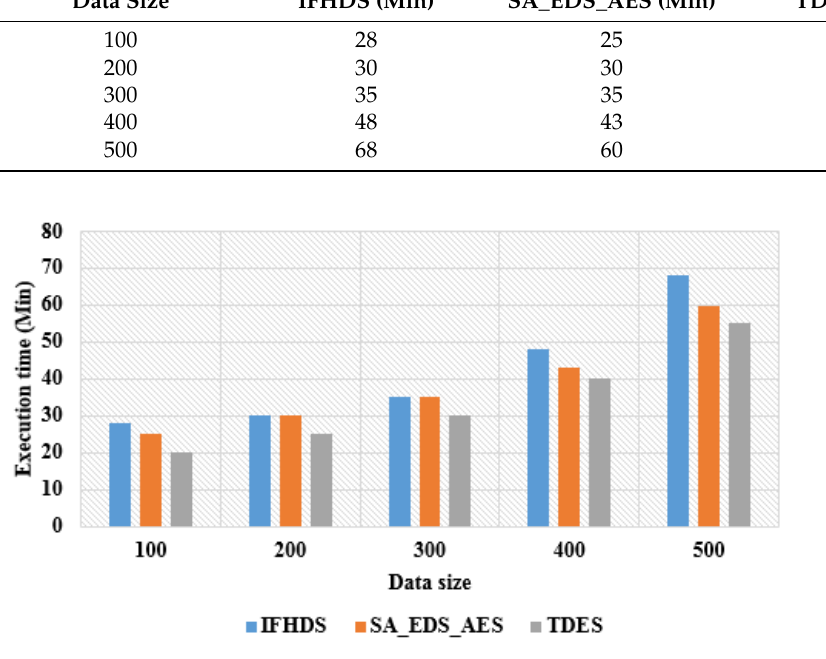
Figure 4. TDES methodology in comparison with existing methods in terms of execution time.